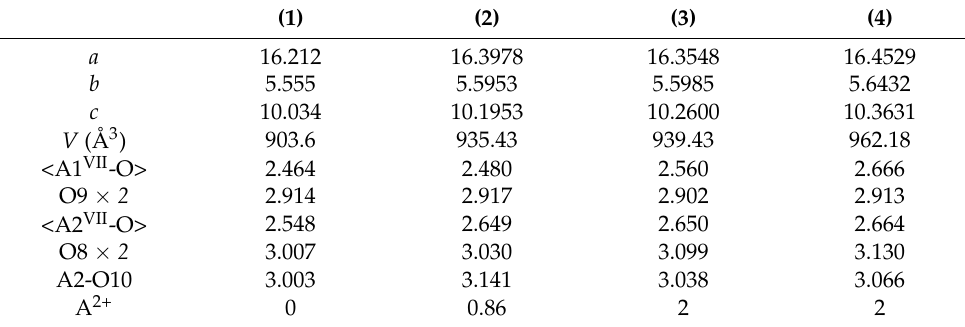
Table 11. Comparison between unit cell parameters (Å) and geometrical features of A1 and A2 polyhedra of isostructural zoisite phases: (1) Zoisite [36]; (2) present study; (3) synthetic Sr-zoisite [6];